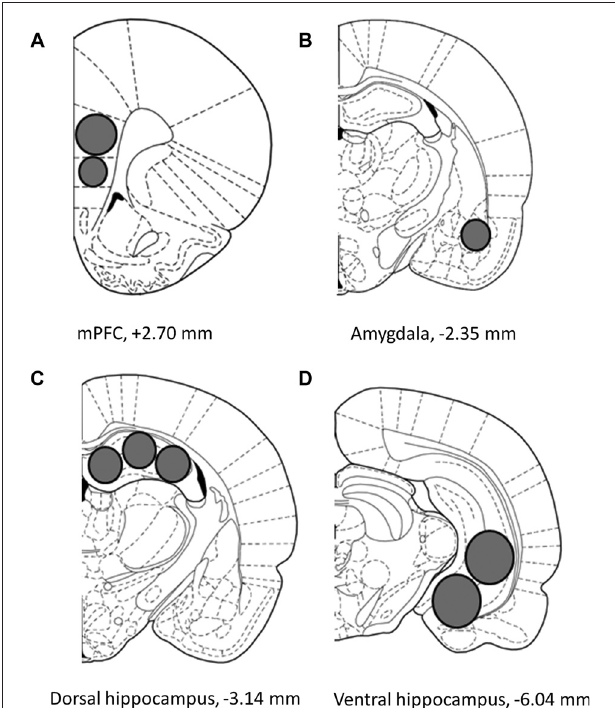
FIGURE 1 | Schematic representation describing the location of the tissue sampled from the (A) medial prefrontal cortex (mPFC), (B) amygdala (AMY), (C) dorsal hippocampus and (D) ventral hippocampus. Images adapted from Paxinos and Watson